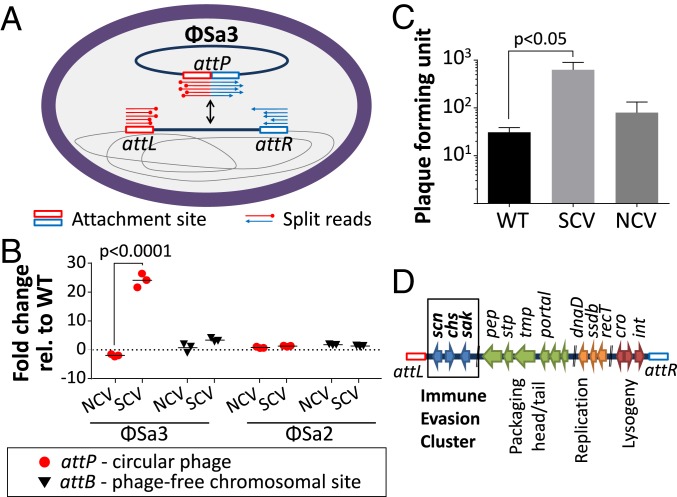
Detection of ΦSa3 prophage activation in the SCV. (A) Whole-genome sequencing using short-read technology and split-read analysis. Split reads (red and blue arrows) corresponding to a circular form of ΦSa3 (attP site) were uniquely detected in the SCV. (B) Quantification by qPCR of circular and excised forms of ΦSa3 and ΦSa2. The relative fold change in the number of circular ΦSa3 phages was significantly different in the SCV compared with the WT. (C) Quantification of phage particles by plaque assay. The y axis indicates change in plaque-forming units compared with wild type, enumerated in 200 µL of filtered supernatant from overnight LB cultures. Error bars represent SD. Statistical analysis was performed comparing SCV strains with the parental strains NRS384 from triplicate experiments and using the 2-tailed Mann–Whitney U test, with P < 0.05 set for statistical significance. (D) Schematic representation of the genetic organization of the ΦSa3 prophage. Genes are represented by arrows that are colored according to functional modules. An atypical characteristic of the ΦSa3 prophage is to encode 3 genes implicated in immune modulation that form the immune evasion cluster: scn encoding the staphylococcal complement inhibitor, chp encoding the chemotaxis inhibitory protein of S. aureus, and sak encoding the staphylokinase.